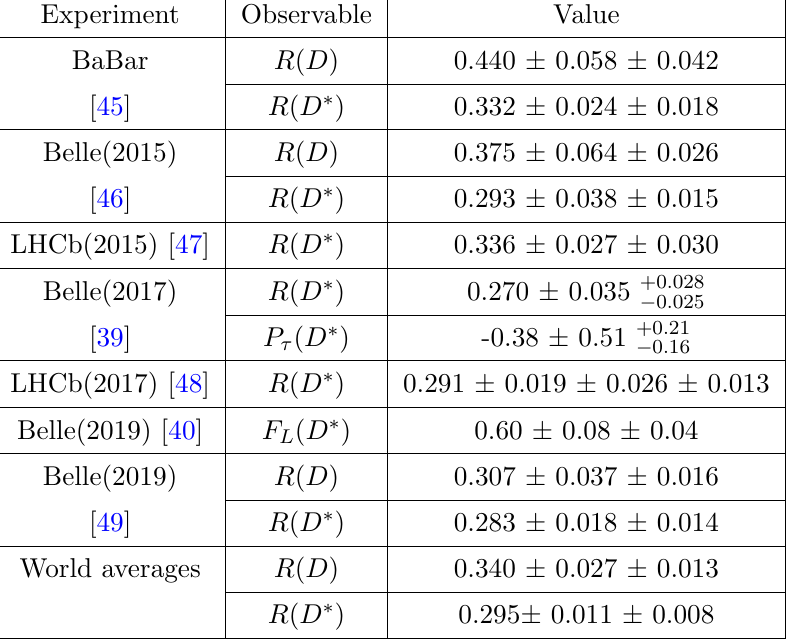
The most general e(cid:11)ective Hamiltonian describing the b ! c(cid:28)(cid:23) 4 G F H = e(cid:11)